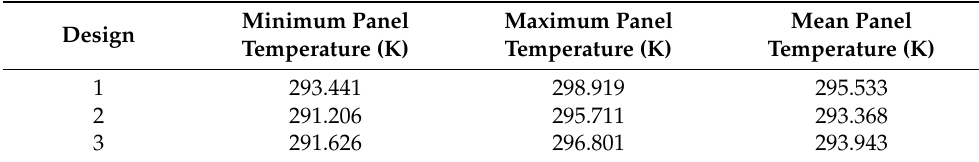
Table 8. Radiant cooling panel surface